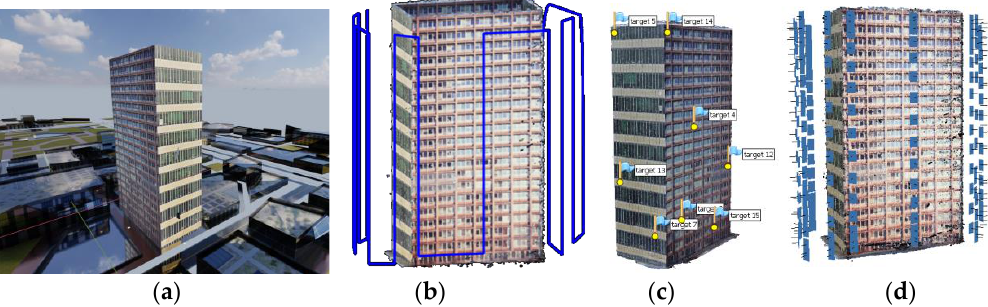
Figure 12. ( a ) The building model. ( b ) Drone flight trajectory (blue line), ( c ) GCPs placed on the building facades, and ( d ) oriented video frames around the